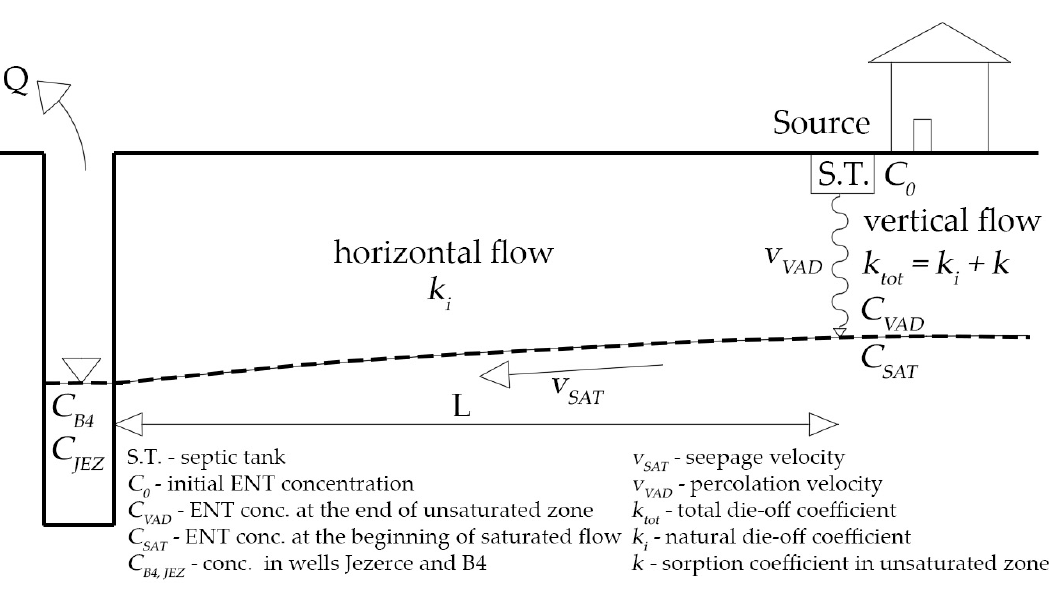
Figure 5. The scheme of the analytical transport